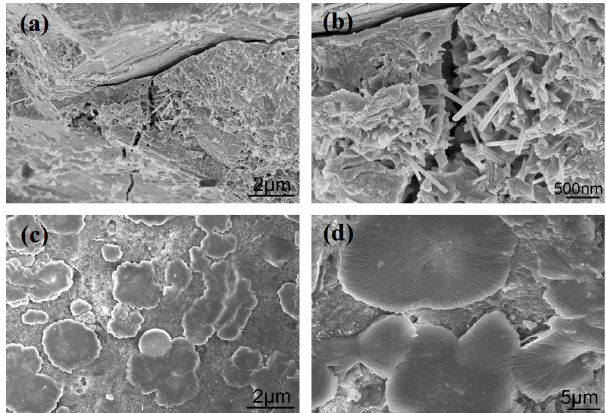
Figure 7. SEM images of S 1 samples ( a , b ) and S 2 samples ( c , d ).